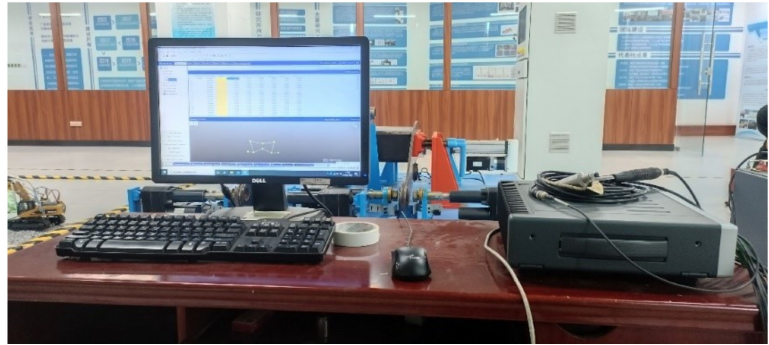
Figure 23. Aluminium alloy front subframe modal test equipment.